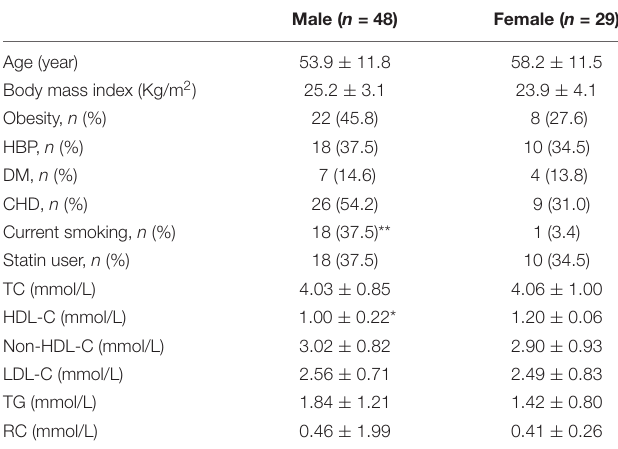
TABLE 1 | Clinical characteristics and fasting blood lipid levels of the two